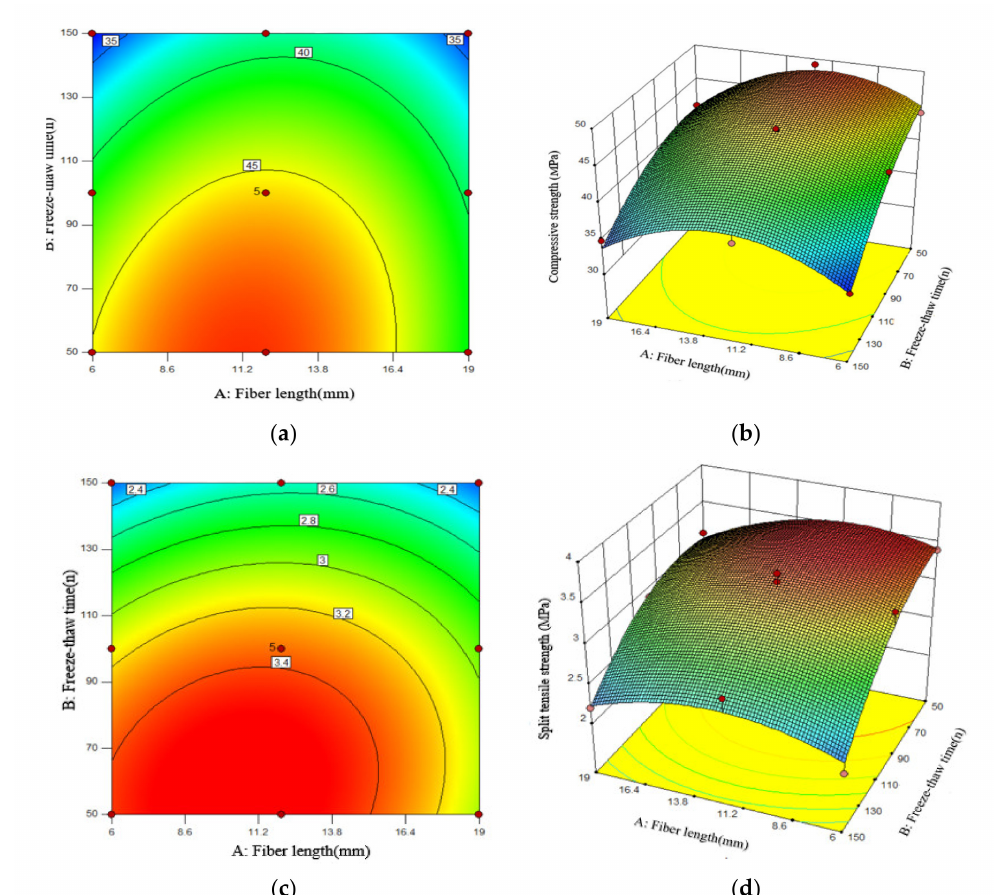
Figure 8. Effects of Factor A, B, and their interactions on R.(PFNSC): ( a ) Surface diagrams of compres- sive strength variation with A and B (2D), ( b ) Surface diagrams of compressive strength variation with A and B (3D), ( c ) Surface diagrams of split tensile strength variation with A and B (2D), ( d ) Surface diagrams of split tensile strength variation with A and B